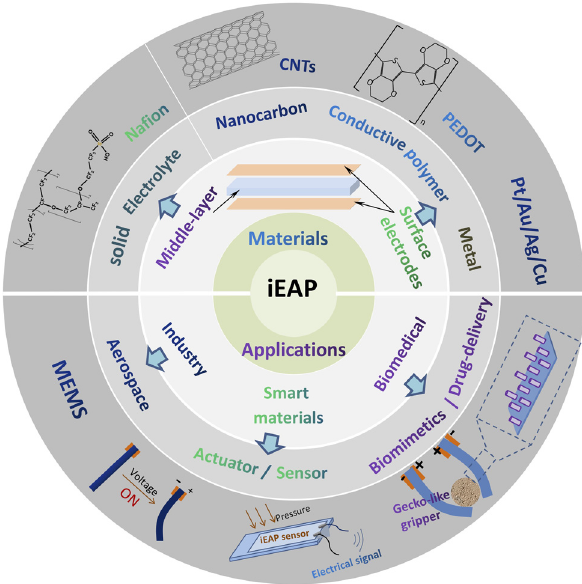
Figure 1: Overview of the materials ’ composition and applications of